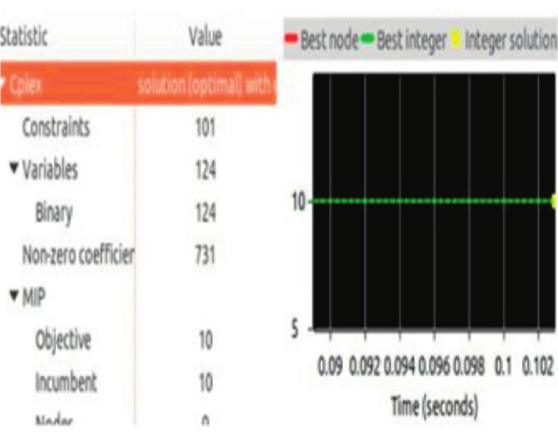
Figure 17: Optimal solution from the solver.